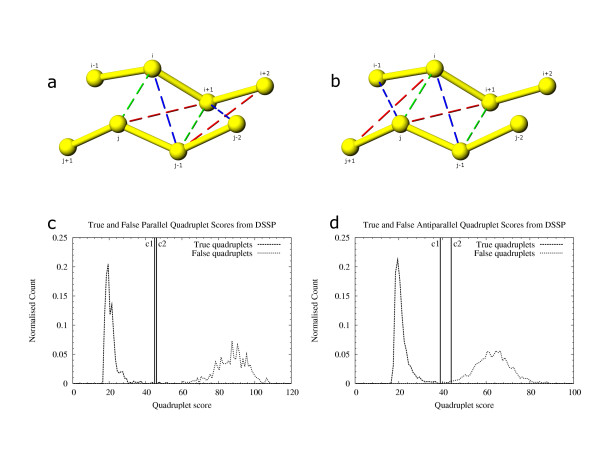
True and false quadruplets generated from DSSP-defined β-strands. 6a, 6b: Residues i, j and i+1, j-1 shown paired with green broken lines form the true quadruplet. For every such quadruplet four false quadruplets (shown with red and blue broken lines) are possible: j, i+1, i+2, j-1 and j-1, i, i+1, j-2 in fig. a; i, j-1, j, i-1 and i, i+1, j, j+1 in fig. b. These quadruplets were scored to find the difference in scores between true and false quadruplets. True and false scores for quadruplets generated from DSSP output for parallel β-strand coordinates (fig. c) and antiparallel β-strand coordinates (fig. d). Cutoff c1 (45) and c2 (46) in fig. c are the scores of the best false quadruplet and the worst correct quadruplet respectively for parallel β-strand data. Cutoff c1 (39) and c2 (44) are the scores of the best false quadruplet and worst correct quadruplet respectively from antiparallel β-strand data. Cutoffs c1 and c2 are used as cutoffs to differentiate between grade 1 and grade 2 quadruplets in our algorithm.